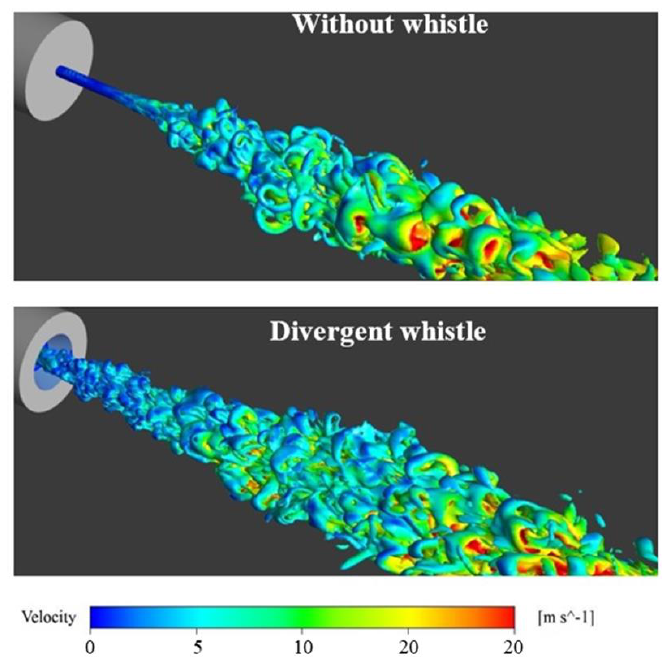
Figure 12. Vorticity iso-surface of the jet with different